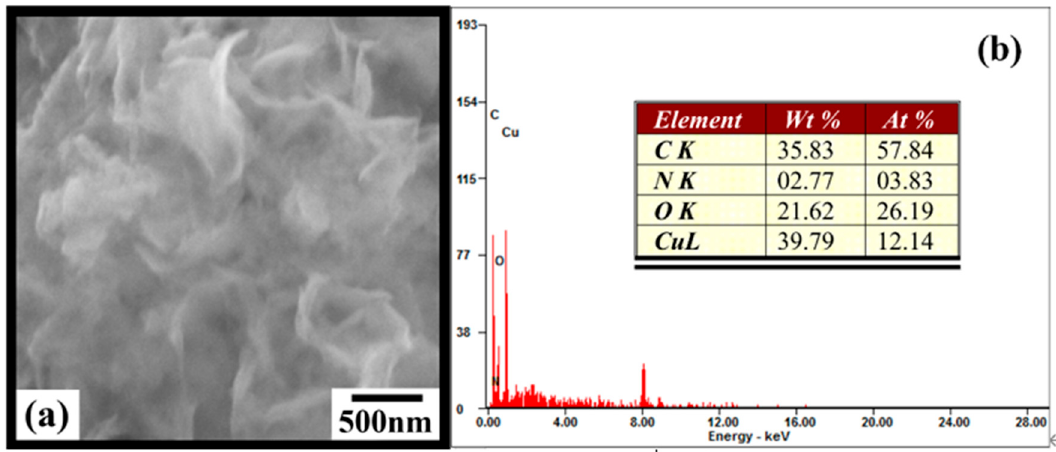
Figure 2. ( a ) SEM image of Cu-TCPP@MOFs. ( b ) EDS analysis of